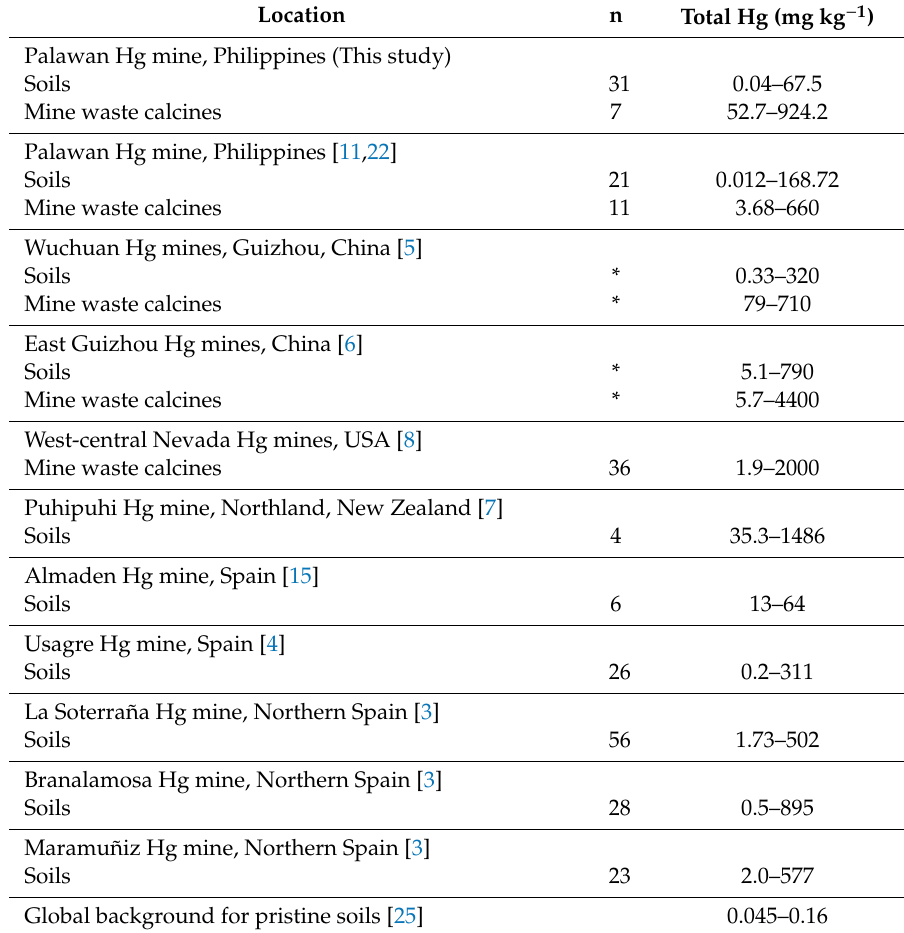
Table 1. Total Hg concentrations in soils and mine waste calcines collected from selected Hg mines